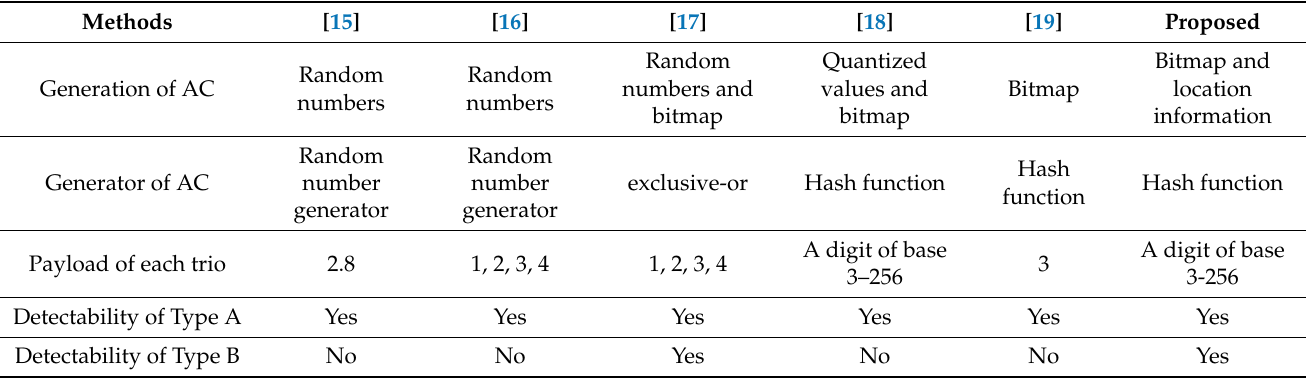
Table 7. Comparisons with other works.